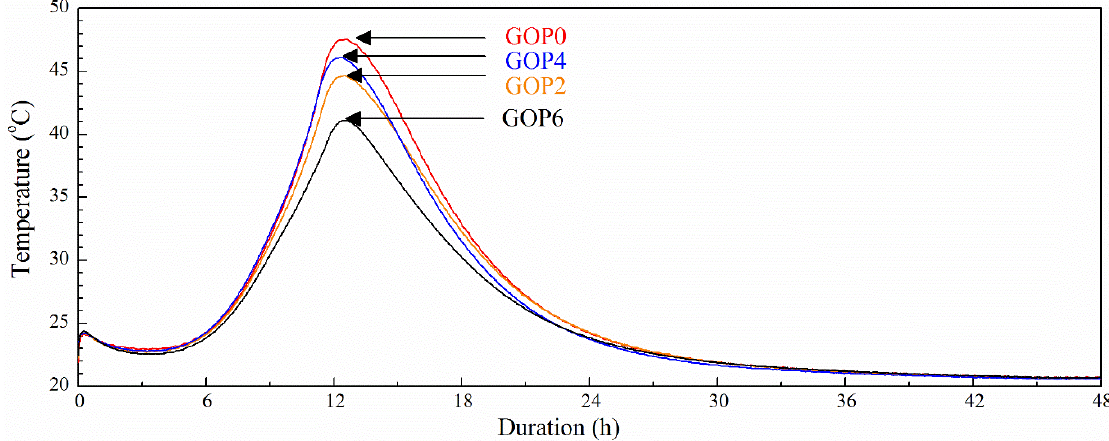
Figure 4. Exothermic reaction (EXO) temperature as a function of time for plasticized cement pastes.